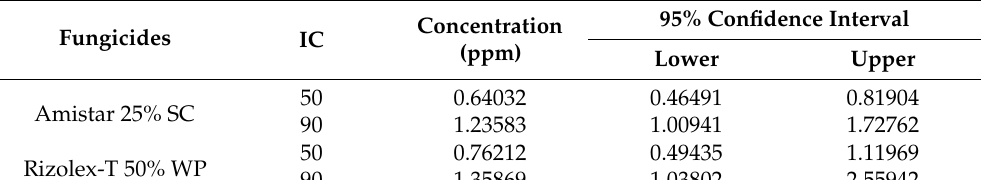
Table 1. The half-maximal inhibitory concentration (IC) values (ppm) for Amistar 25% SC and Rizolex-T 50% WP.